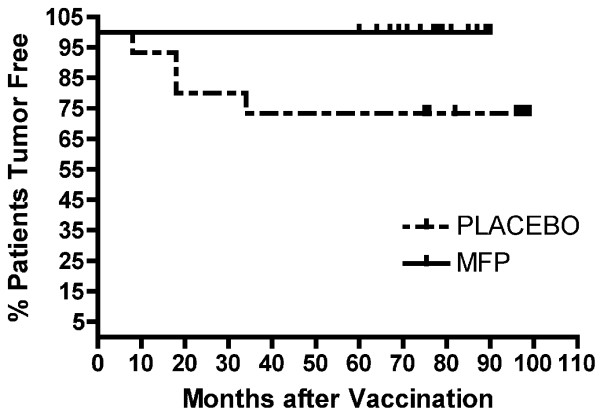
Kaplan-Meier survival curves. The PRISM program was used to construct the curves for the placebo and M-FP immunized patients. M-FP, oxidized mannan conjugated to MUC1 fusion protein.